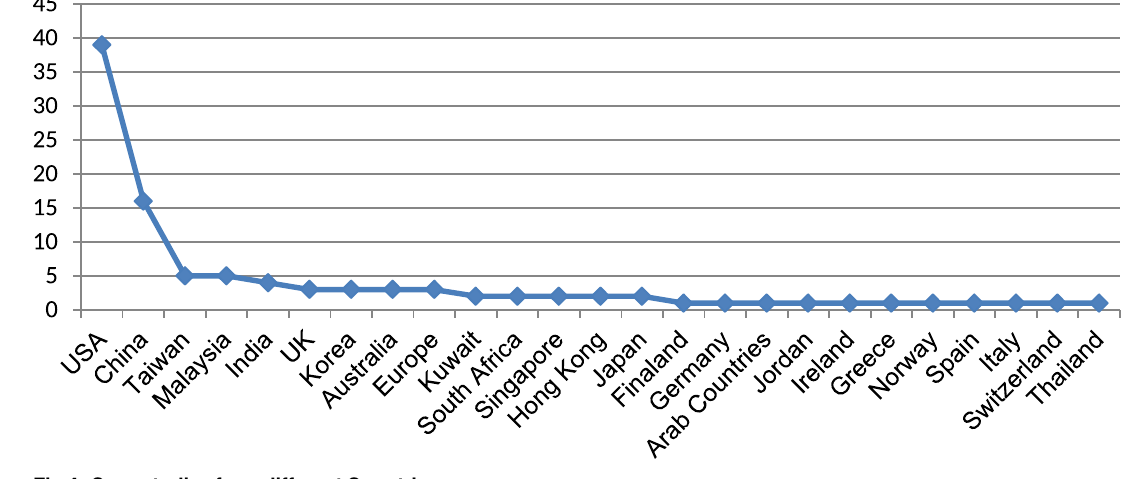
Fig 4. Case studies from different